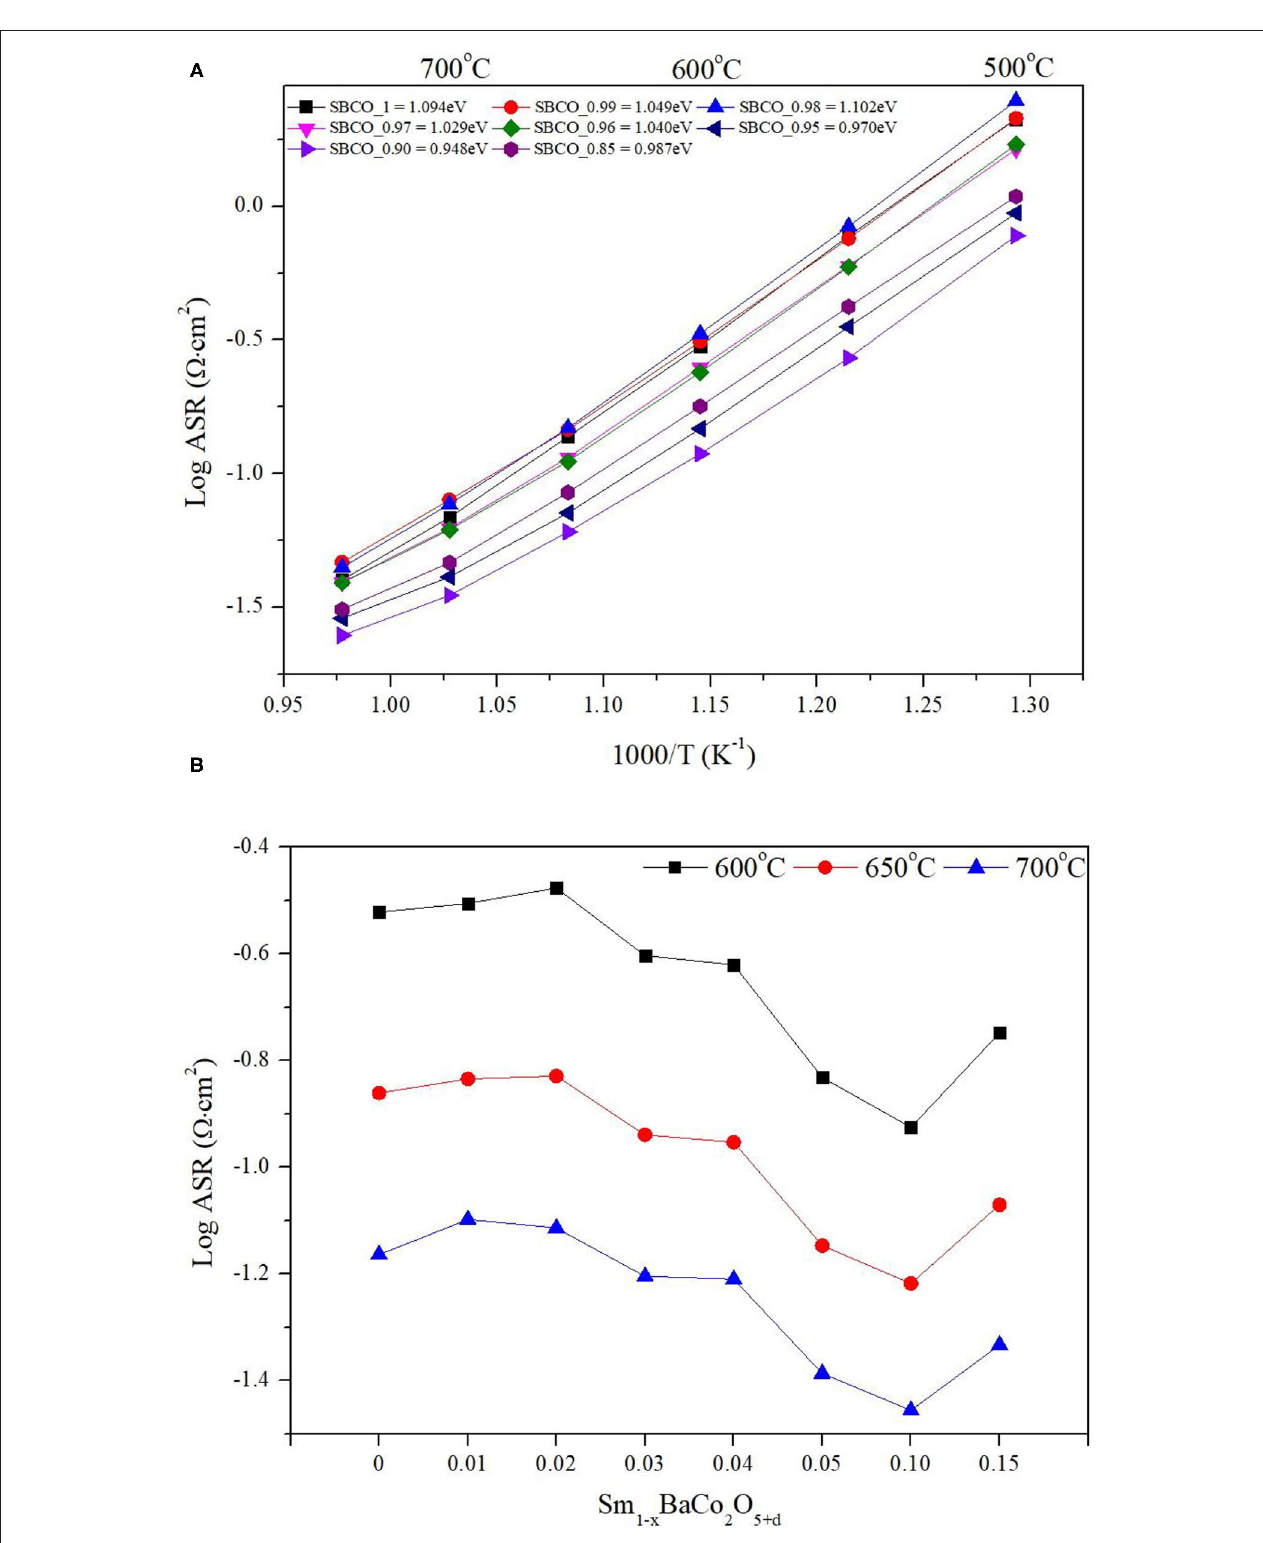
FIGURE 2 | Area specific resistance (ASR) results of (A) Sm 1 − x BaCo 2 O 5 + d oxide systems with respect to temperature, and (B) ASR dependence of cathodic polarization with respect to compositions at 600, 650, and 700 ◦ C.